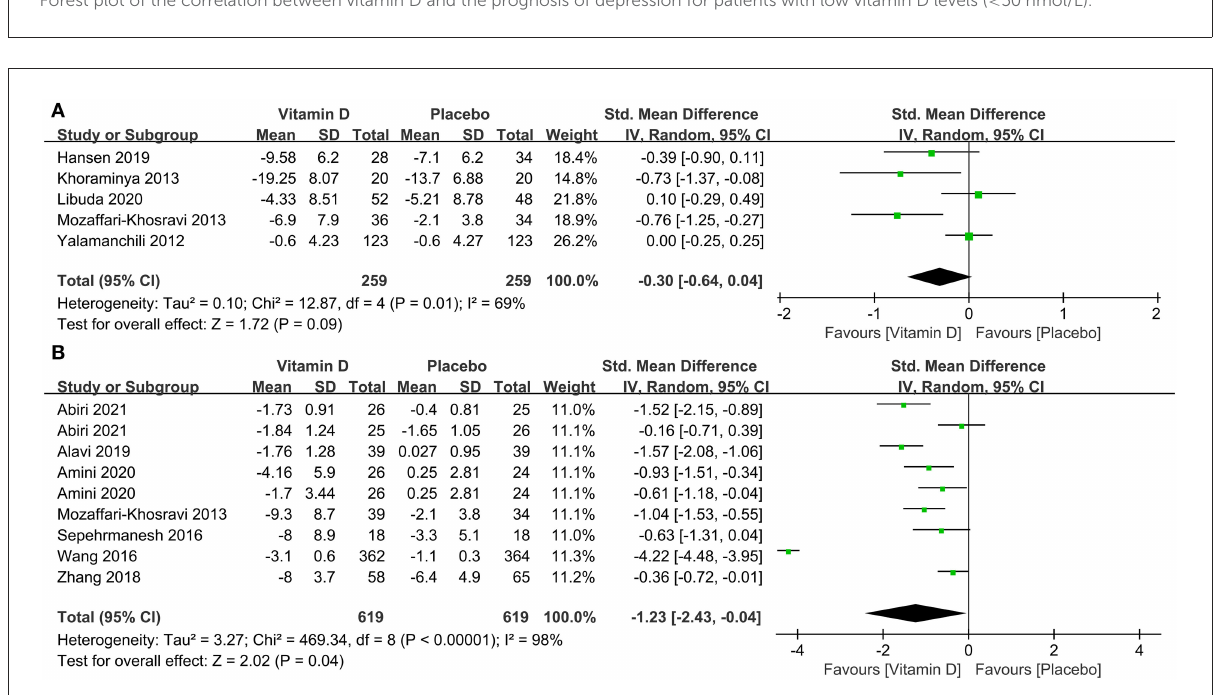
FIGURE7 Forest plot of the correlation between supplementary doses of vitamin D and the prognosis of depression. (A) low doses ( ≤ 2,800 IU/day); (B) high doses ( > 2,800 IU/day).